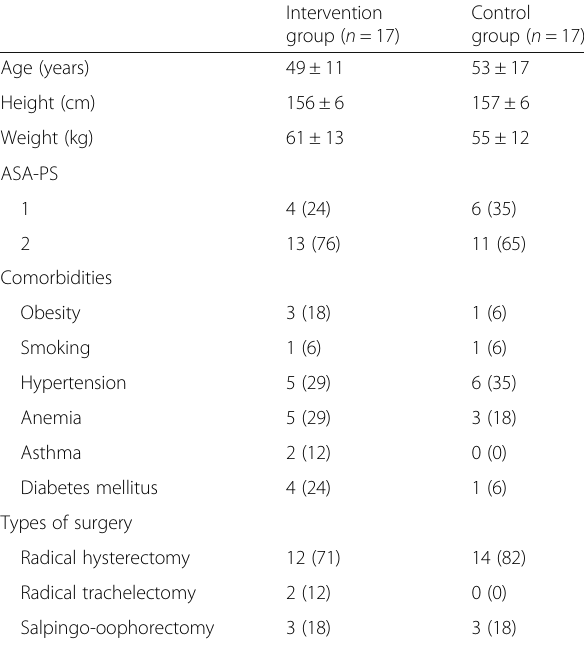
Table 1 Patient characteristics